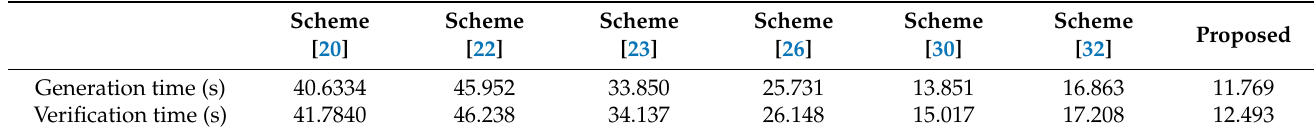
Table 6. Computation time for the proposed and the existing algorithms